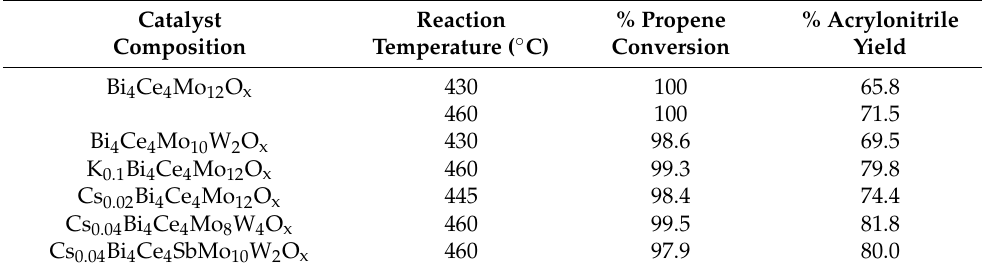
Table 2. Promoting effect of bismuth-cerium molybdate propene ammoxidation catalyst system (See reference for specific reaction conditions)